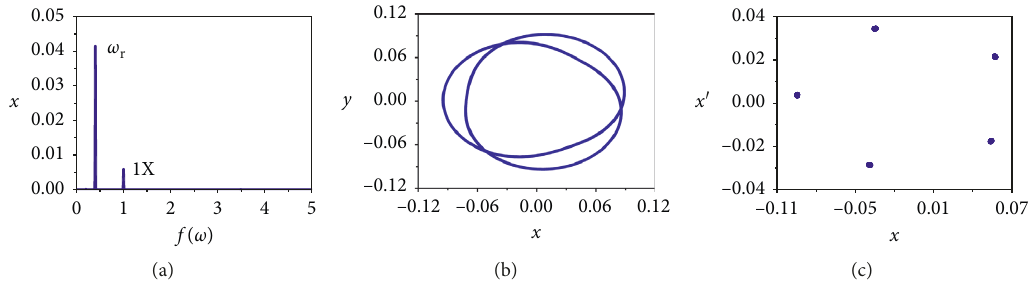
Figure 6: The 5T-periodic response of the rotor/seal system at s rotor. (c) The Poincar´e map of the x coordinate.